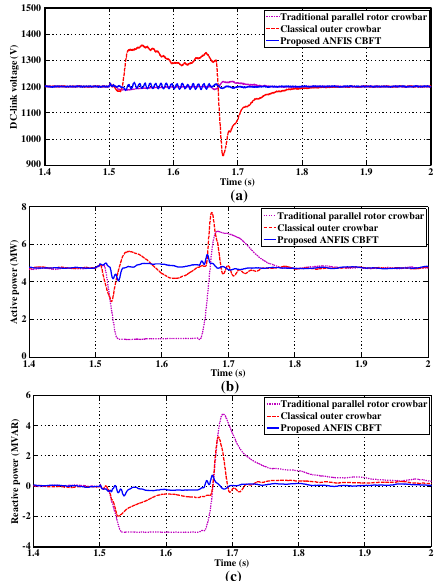
Fig. 9 Comparison of measured values for traditional, classical, and proposed protection techniques during single-phase to ground fault ( a ) DC-link voltage; ( b ) active power; ( c ) reactive